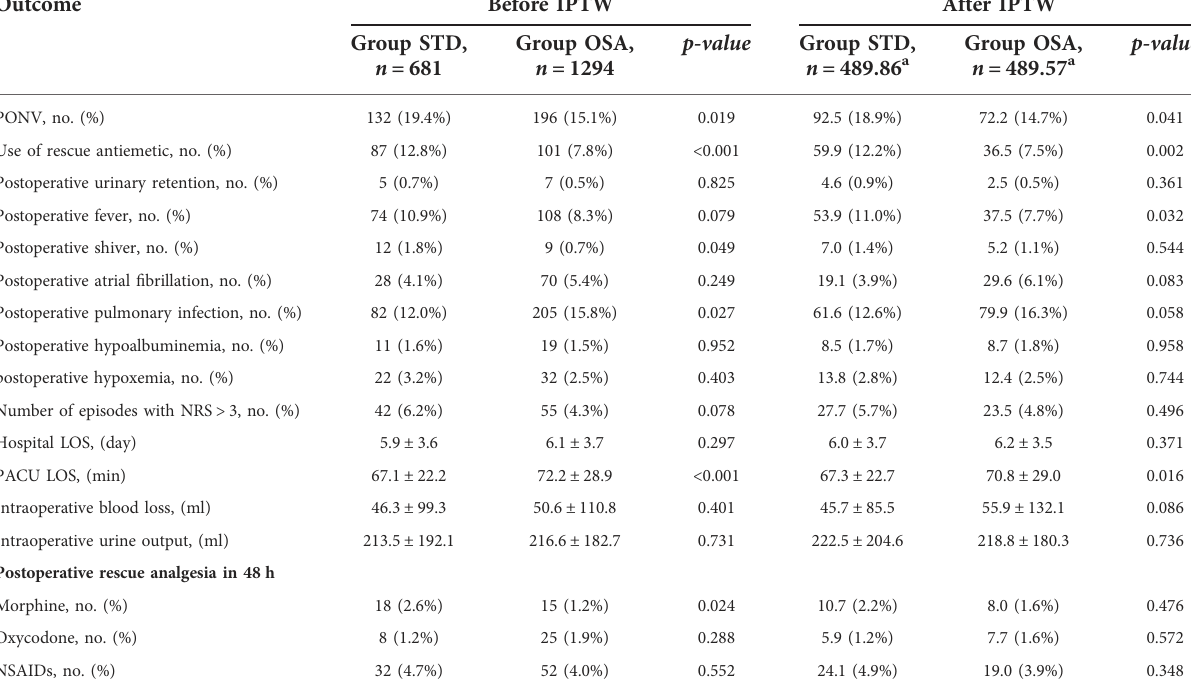
TABLE 2 Outcome analyses. Outcome Before IPTW